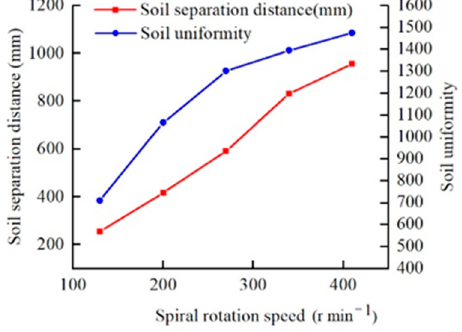
Figure 10. Relationship curves between rotation speed and D W , E.